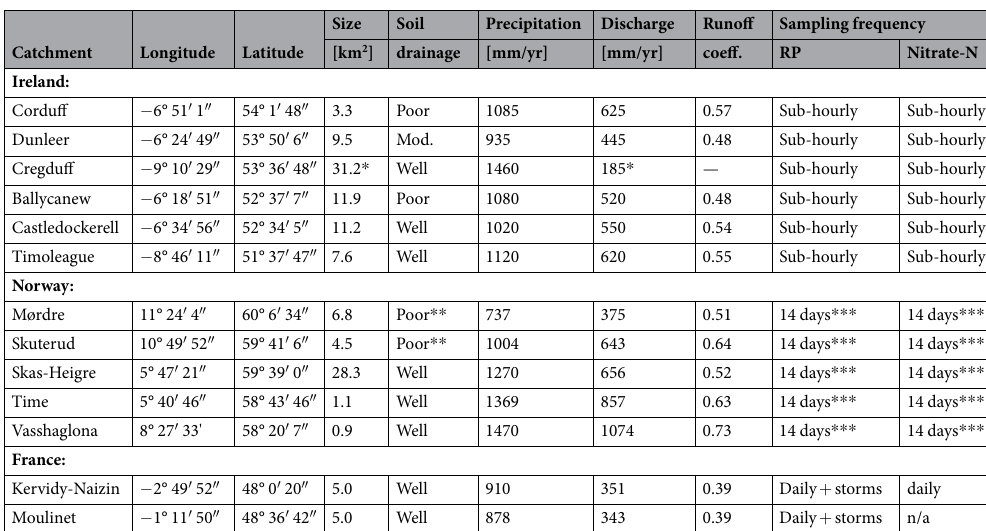
Table 1. Catchments characteristics. Annual precipitation, river discharge and runoff coefficient were averaged for hydrological years (1 st October 2009 – 30 th September 2015). * Estimated spring contribution zone, ** extensively tile drained, *** volume proportional composite